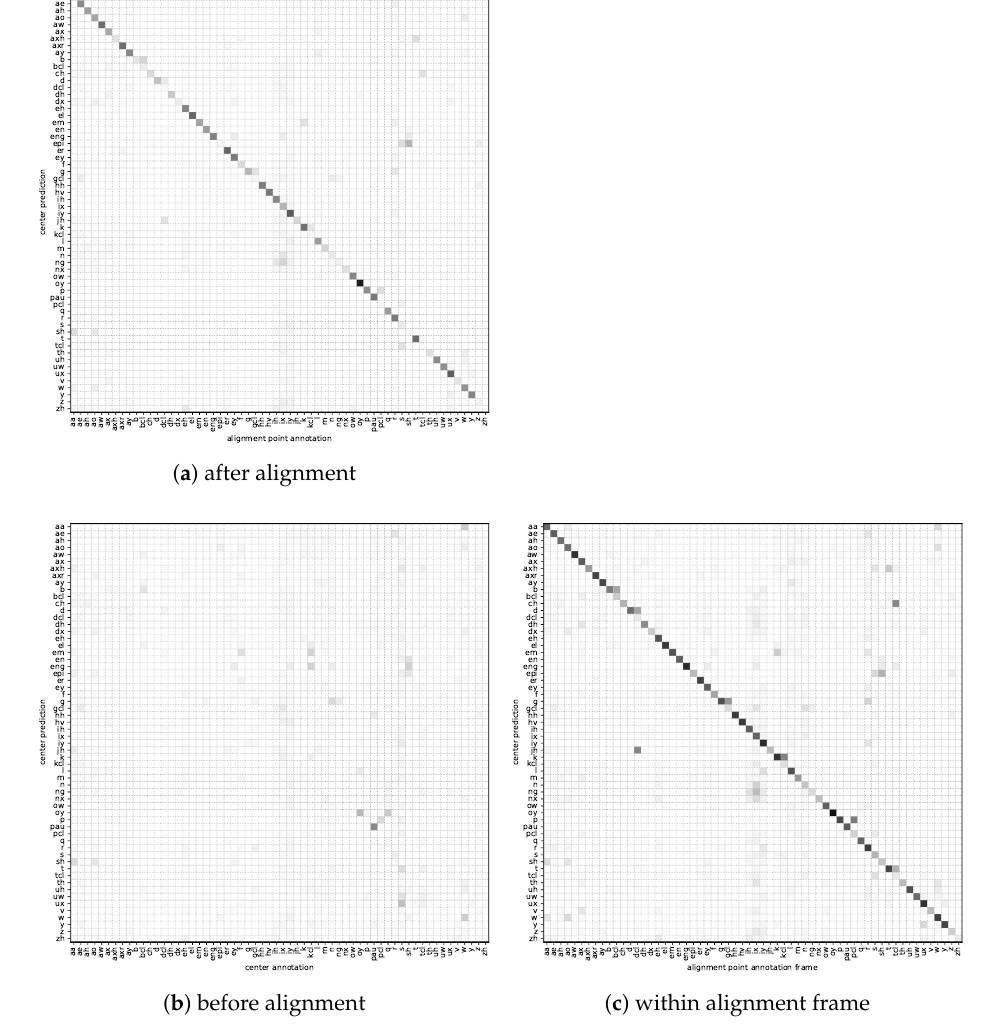
Figure A1. Alignment evaluation overview for model W2P. For each predicted phoneme on the y -axis the relative frequency of the corresponding phoneme annotation on the x -axis. Color scale [0, 1] from white to